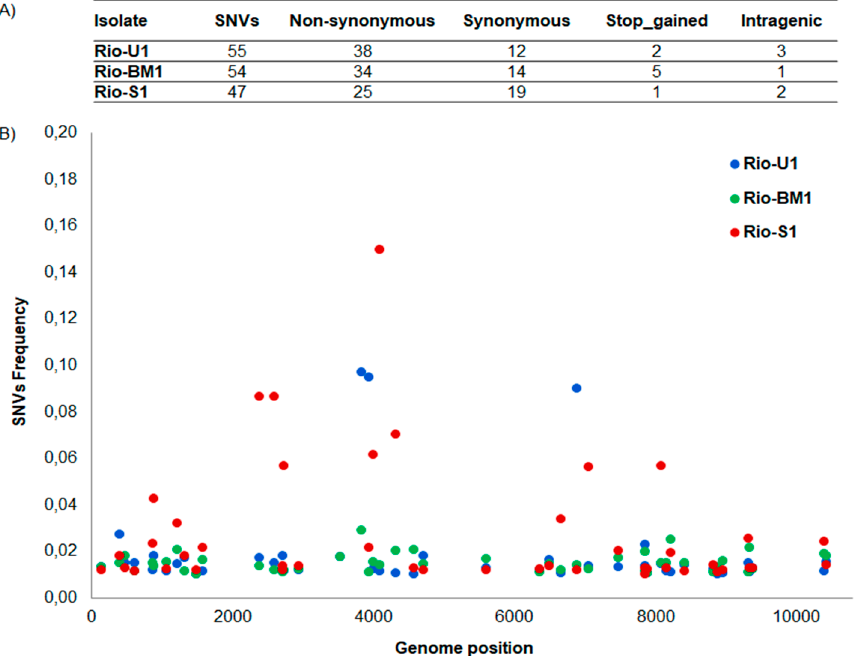
Figure 2. Characterization of single nucleotide variants (SNVs) in the three ZIKV isolates with frequency value >0.01. ( A ) Number of SNV types observed. ( B ) Genome position of SNVs spanning the genome of the three isolates.